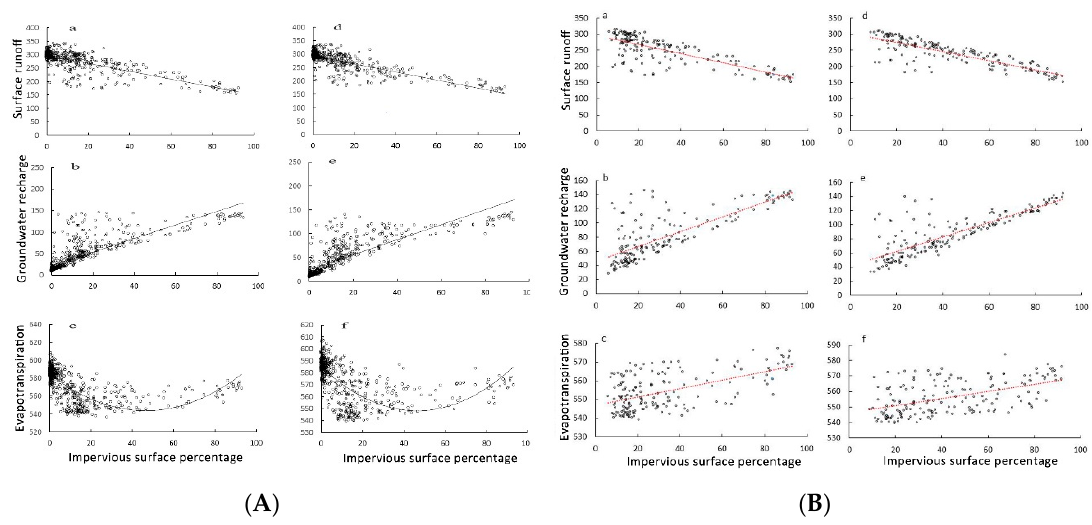
Figure 7. The correlations of groundwater recharge, surface runoff, and evapotranspiration with impervious percentages: in the whole Beijing area ( A ); and in urban region of Beijing ( B ) (( a – c ) 2000; and ( d – f ) 2012). Table 6. Correlations between the impervious percentages and water balance components in urban region of Beijing in 2000 and 2012.